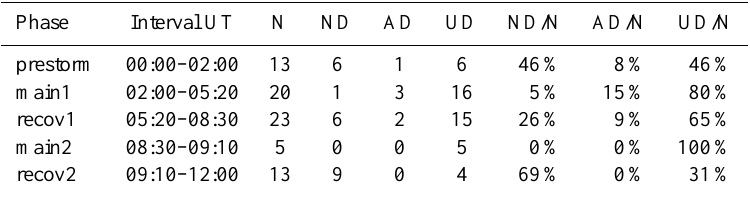
Fig. 4. Sketches illustrating criteria for definition of three IB energy dispersion types. P1 and P2 panels correspond to lower and higher energy bands. Vertical lines mark confidence intervals of IB determination (0 ◦ and 90 ◦ fluxes are not shown inside these intervals). Table 2. Statistics of observation of different types of IB energy dispersion during specific phases of the storm. The phases are defined according to Sym-H ∗ . IB dispersion type was determined for P1, P2 energy